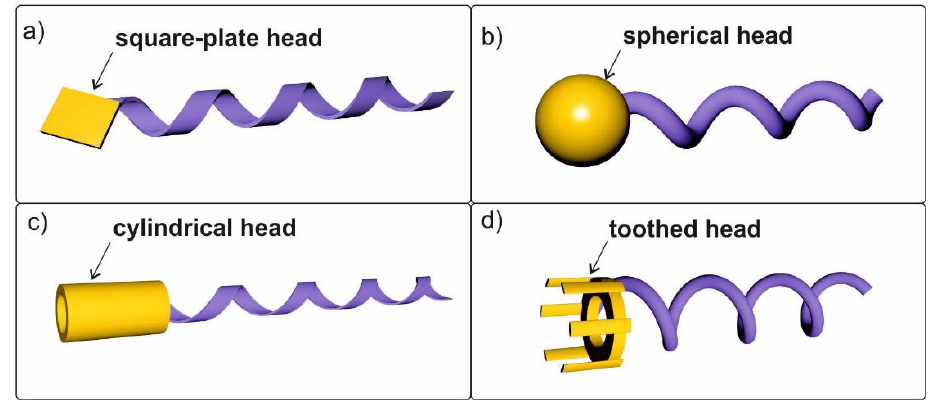
Figure 9. Helical swimmers with various magnetic heads: ( a ) square-plate-head swimmer; ( b ) spherical-head swimmer (GLAD); ( c ) cylindrical-head swimmer; ( d ) toothed-head swimmer.